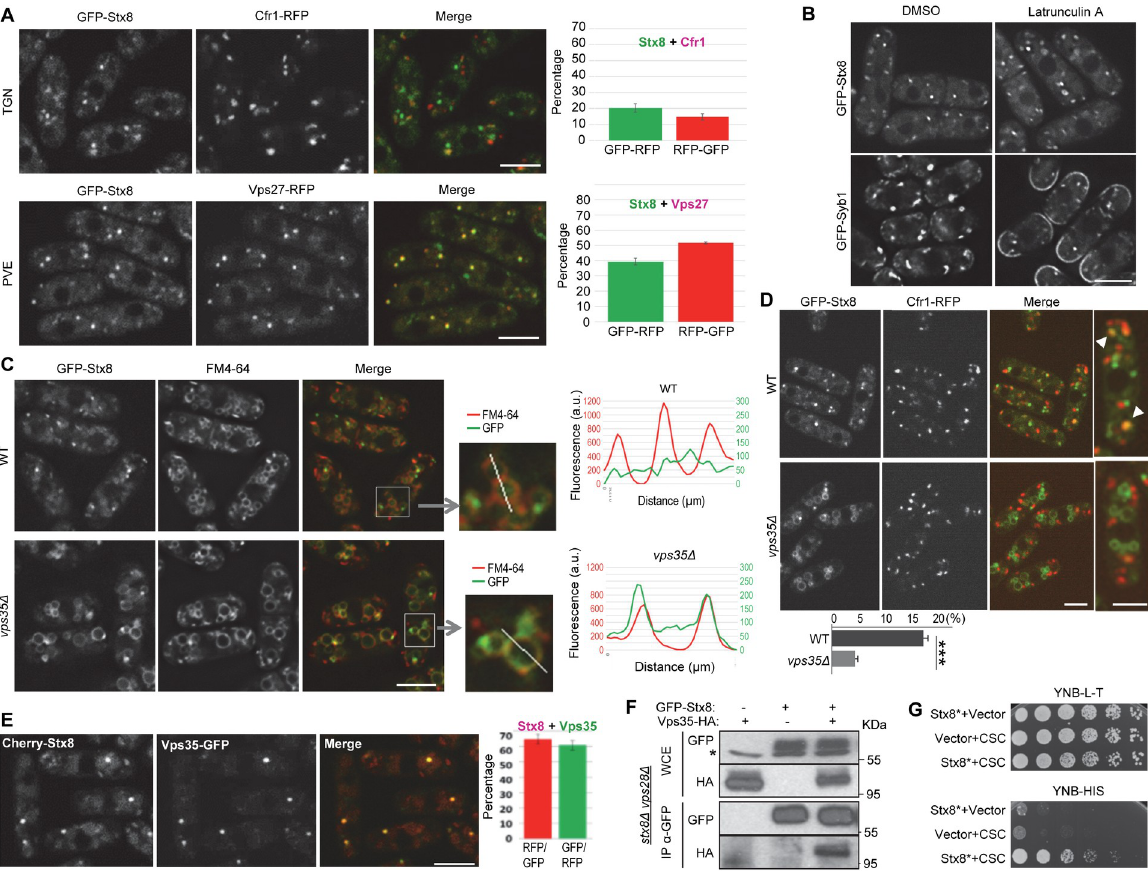
Fig 3. Stx8 cycles between the trans -Golgi network (TGN) and the prevaculolar endosome (PVE) in a retromer-dependent fashion. (A) Colocalization between GFP-Stx8 and the TGN marker Cfr1-RFP (upper panels) or the PVE marker Vps27-RFP (lower panels). The experiments were performed two times, and a minimum of 400 GFP-Stx8 dots were scored in each experiment. The mean and standard deviation of the results are shown (right panels). For better accuracy, both the percentage of GFP-Stx8 dots that colocalized with Cfr1-RFP or Vps27-RFP dots and the percentage of Cfr1-RFP or Vps27-RFP dots that colocalized with GFP-Stx8 dots were determined. (B) Wild type (WT) cells bearing GFP-Syb1 or GFP-Stx8 were treated with dimethyl sulfoxide (DMSO; solvent) or latrunculin A for 20 minutes and photographed. (C) Distribution of GFP-Stx8 in WT and vps35 Δ cells. GFP-Stx8 colocalization with FM4-64 is shown. Enlargement of representative vacuoles from the same strains are shown in the central panels. The right panels show line-scans of GFP and FM4-64 fluorescence intensities (a.u., arbitrary units) across the vacuoles, as indicated in the enlargements. (D) Colocalization between GFP-Stx8 and Cfr1-RFP in WT and vps35 Δ strains. The right panels show enlarged cells. Arrowheads in the WT denote colocalization. The mean, standard deviation and statistical significance (Student’s t-test. P value 0.0002) of the colocalization percentages from three independent experiments is shown in the lowest panel. (E) Colocalization between Cherry-Stx8 and Vps35-GFP. The mean and standard deviation of the results are shown (right panels). For better accuracy, both the percentage of Cherry-Stx8 dots that colocalized with Vps35-GFP dots and the percentage of Vps35-GFP dots that colocalized with Cherry-Stx8 dots were determined. Images are single planes captured with by confocal spinning disk microscopy (A, C, D and E) and with a DeltaVision system (B). Scale bar, 5 μ m. (F) Stx8 and Vps35 coimmunoprecipitate. Cell extracts from stx8 Δ vps28 Δ strains carrying GFP-Stx8 and/or Vps35-HA were analyzed by western blot using anti-GFP or anti-HA monoclonal antibodies before (WCE, whole-cell extracts) or after immunoprecipitation (IP) with a monoclonal anti-GFP antibody. The asterisk denotes an unspecific band. (G) Serial dilutions of the Saccharomyces cerevisiae host strain AH109 strain transformed with empty plasmids (vector) and/or with plasmids expressing Stx8 � (Stx8 lacking the TM helix) and/or a fusion Vps29-Vps35-Vps26 protein (CSC) were spotted on yeast nitrogen base medium without leucine and tryptophan (YNB-L-T) and without histidine (YNB-H) and incubated at 30˚C for four days. Growth on YNB-H shows direct interaction between Stx8 � and